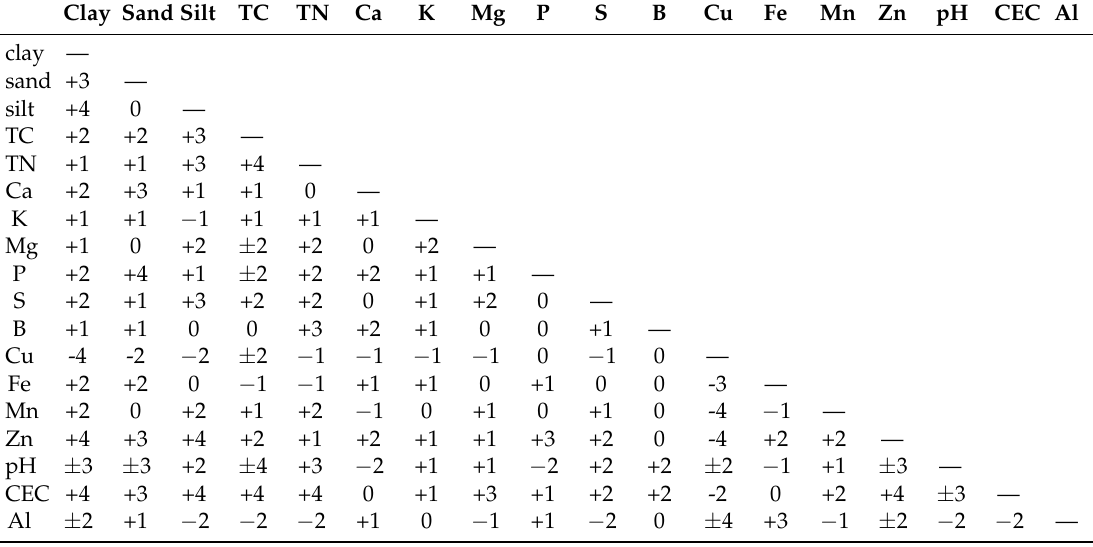
Table 2. Correlation matrix for soil properties. Correlations were tested for each site individually. The numbers indicate the numbers of sites where the correlation coefficient (r) was statistically significant ( p < 0.05; disregarding potential spatial autocorrelation). The sign of the r values ± indicates that there were both significant positive correlations and significant negative correlations between the two variables considered. TC = total carbon, TN = nitrogen, and CEC = cation exchange